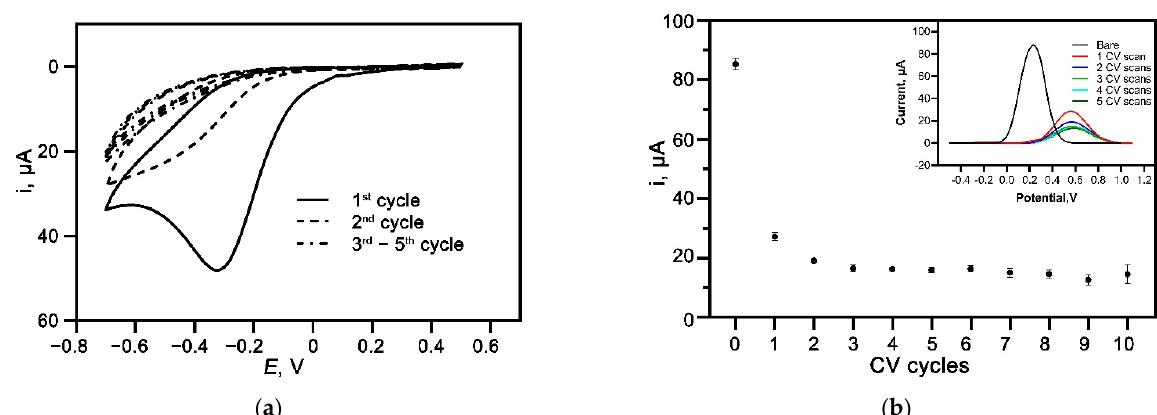
Figure 3. ( a ) Studies of CV for, in situ, electrografted carboxyphenyl diazonium salt generated from 2 mM 4-aminobenzoic acid and 2 mM NaNO 2 in 0.5 M HCl at a scan rate of 100 mV s − 1 . ( b ) Distribution of the oxidation peak current for SPCE-ABA electrode at different CV cycles. Inset: SWV of bare SPCE and SPCE-ABA with different CV cycles. Measurement was performed at a scan rate, amplitude, and frequency of 125 mV s − 1 , 25 mV, and 25 Hz, respectively, in 5 mM [Fe(CN) 6 ] 4 − /3 and 1 mM KCl.